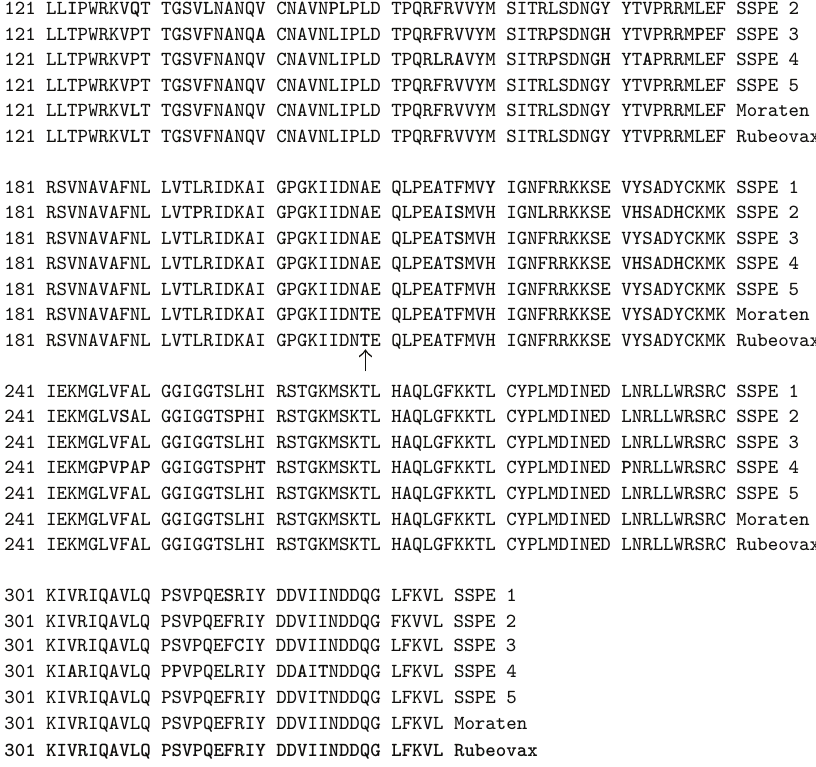
Figure 1: Primary sequence comparison of M protein genes from five SSPE cases [20] and two MeV vaccine strains. Accession numbers SSPE1 (London) AF503528; SSPE2 (Nottingham) AF503530; SSPE3 (Cardiff) AF503531; SSPE4 (Belfast87) AF503526; SSPE5 (Belfast88) AF503524; Moraten (vaccine) AF266287; Rubeovax (vaccine) AF266289.